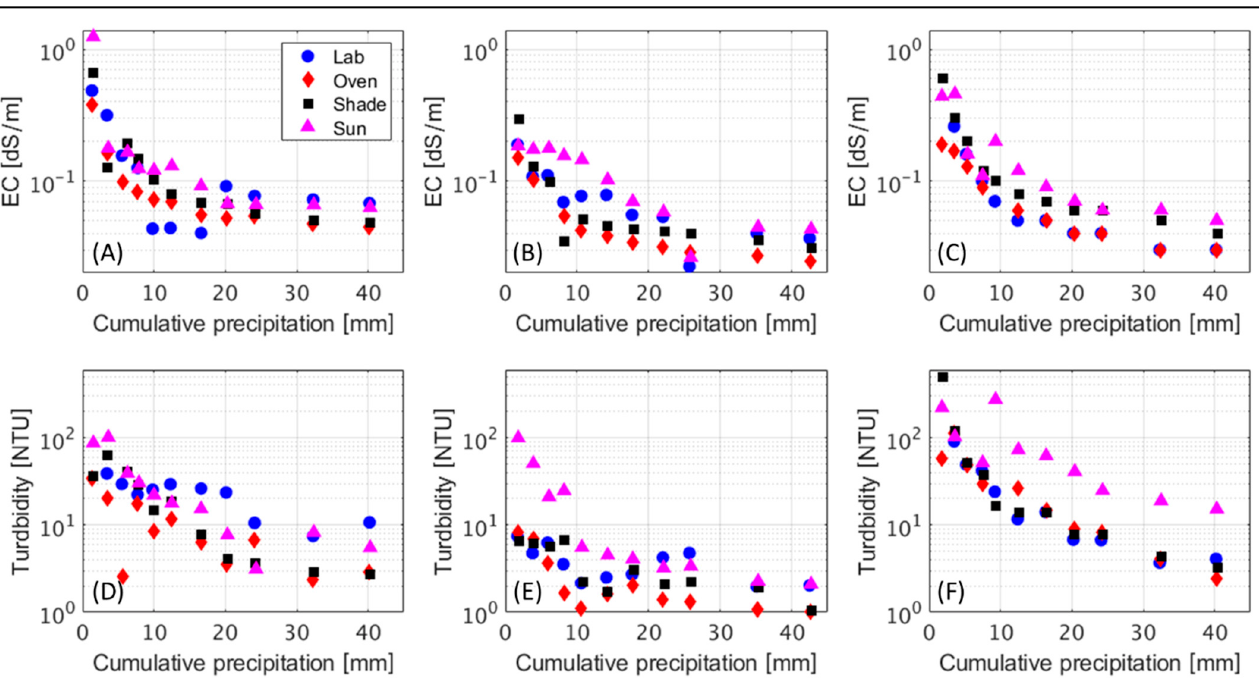
Figure 10. Measured EC ( A – C ) and turbidity ( D – F ) of drained water obtained for all examined setups at the first rain simulation ( A , D ), second rain simulation ( B , E ), and third rain simulation ( C , F ).